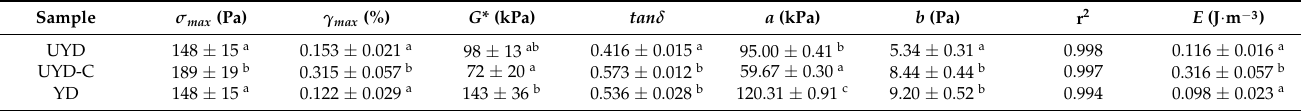
Table 1. Limit parameters of the linear viscoelastic region at 25 ◦ C: limit stress ( σ max ), limit strain ( γ max ), complex modulus ( G *), loss tangent ( tan δ ), as well as the fit parameters of Equation. (1) ( a and b ) and result of the integral ( E , from Equation (2)) of unyeasted wheat dough (UYD), CH-enriched unyeasted wheat dough (UYD-C) and yeasted wheat dough (YD). T = 25 ◦